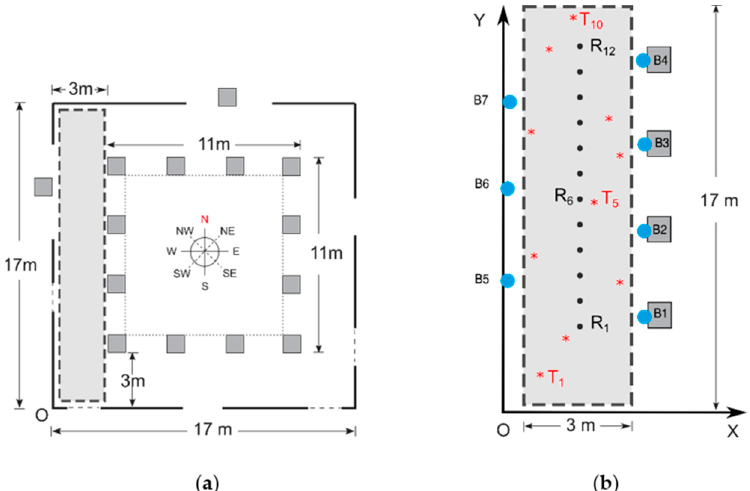
Figure 6. View of the second scenario where TB2 is located.